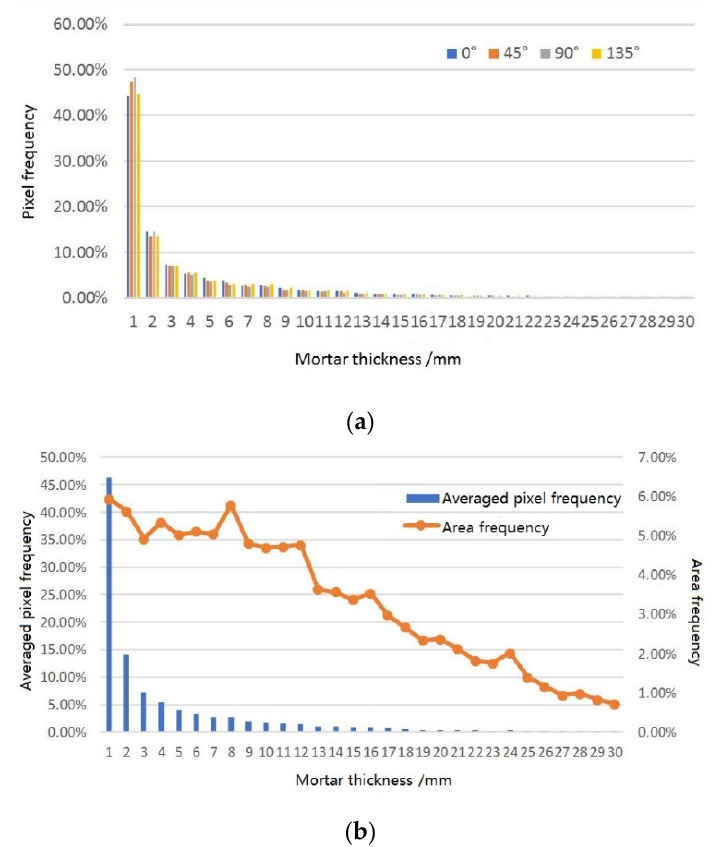
Figure 5. ( a ) Pixel frequency; ( b ) thickness spectrum.